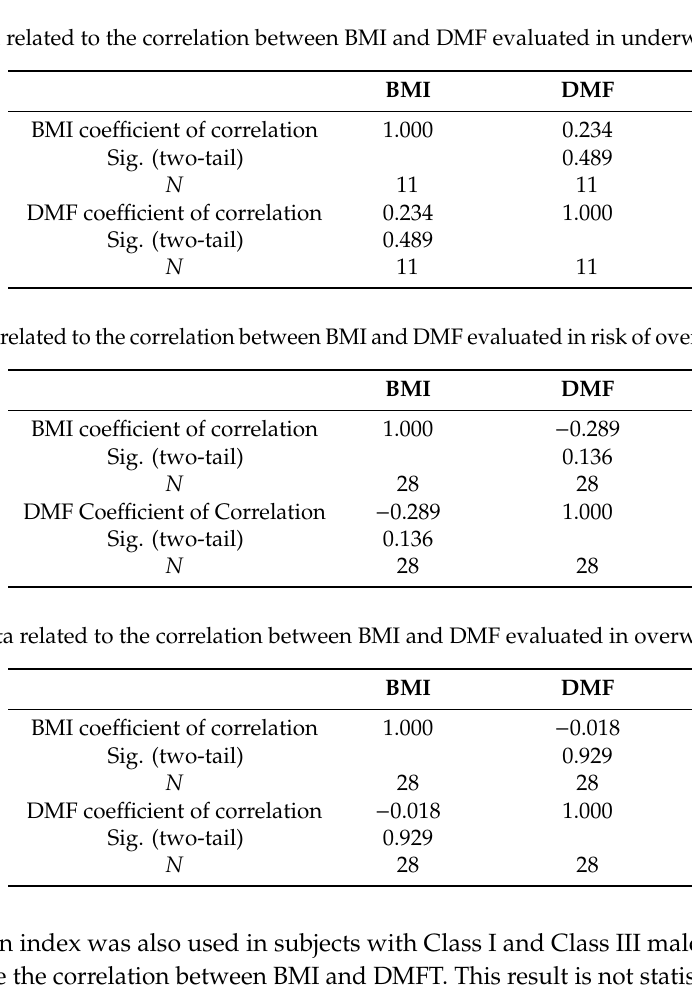
BMI coe ffi cient of correlation Sig. (two-tail) N DMF coe ffi cient of correlation Sig. (two-tail) N * The correlation is significant at the 0.05 level (two-tail).